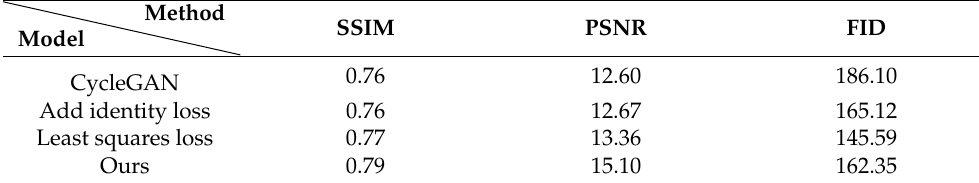
Figure 11. Ablation study of side face: ( a ) Input face photos. ( b ) CycleGAN. ( c ) Add identity loss. ( d ) Use the least squares loss function. ( e ) Ours. ( f ) Ground truth. Table 4. Quantitative results of improved CycleGAN for